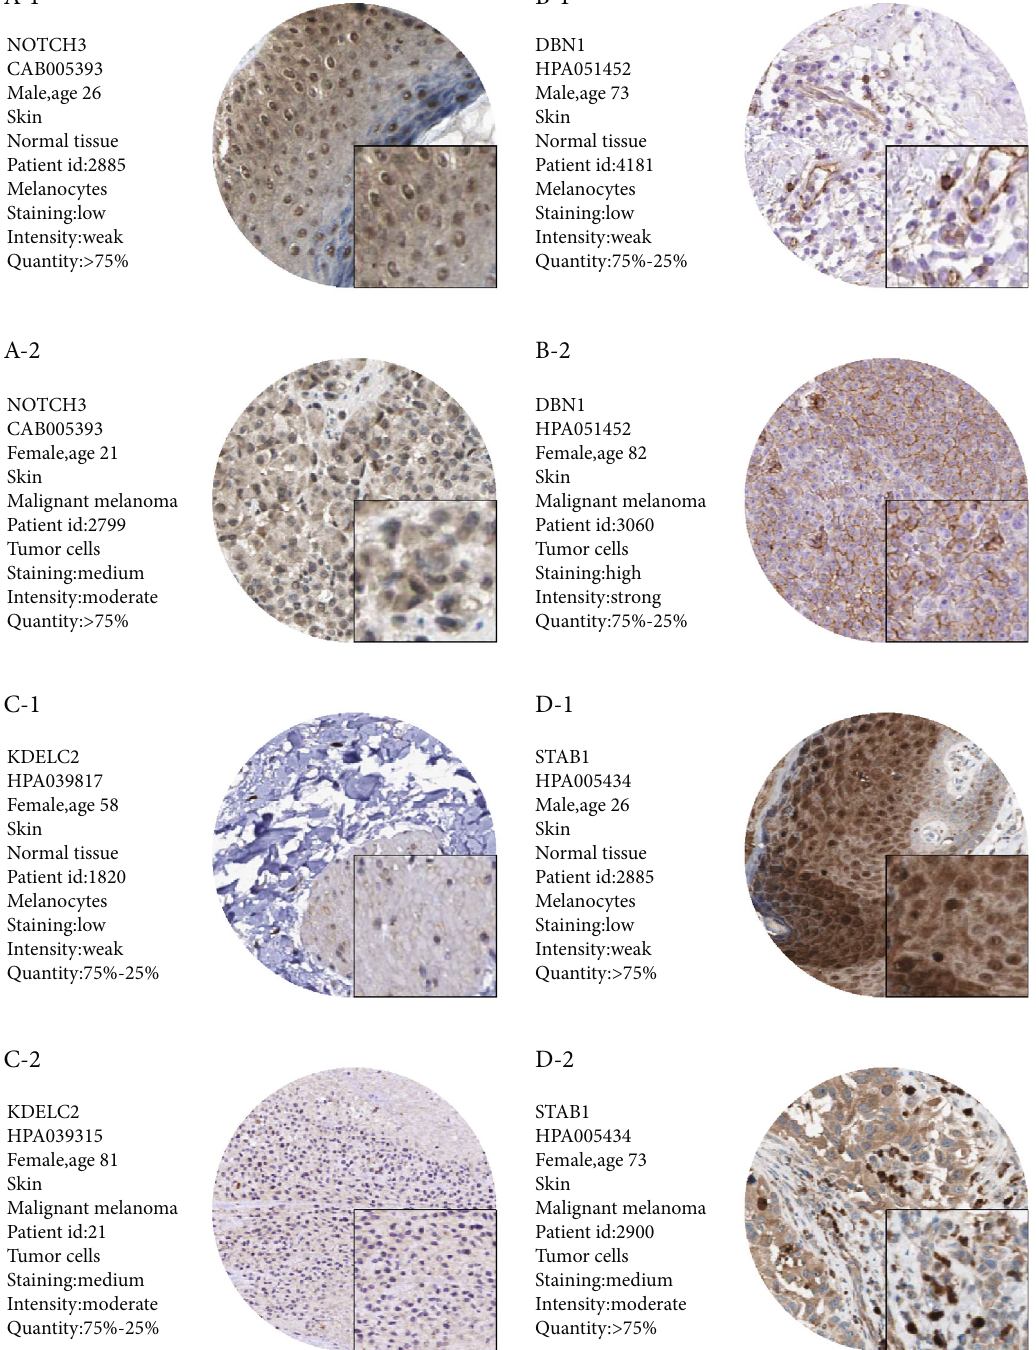
Figure 7: Di ff erences in protein expression levels of NOTCH3, DBN1, KDELC2, and STAB1 were veri fi ed in the HPA database. In the immunohistochemical samples corresponding to each gene, the staining degree of melanoma tissue was higher than normal skin